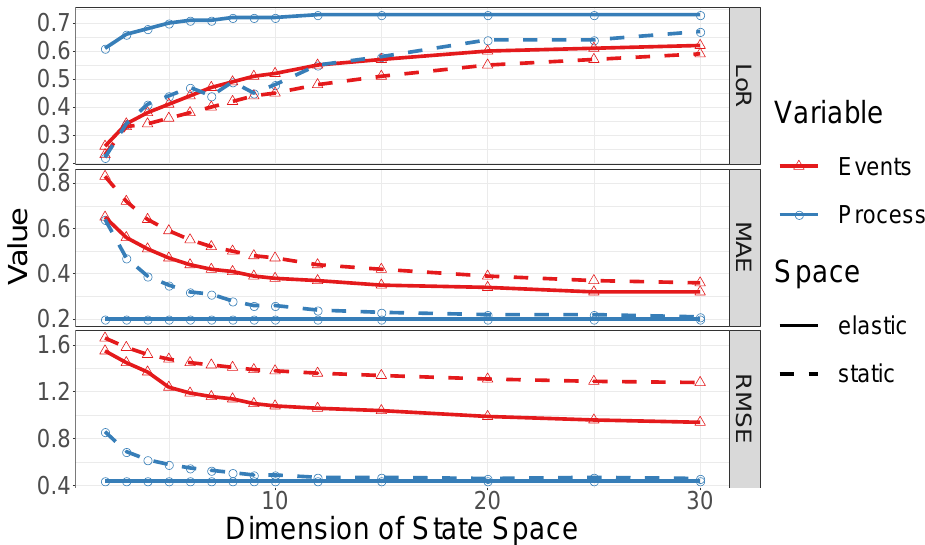
Figure 8. Evaluation of prediction accuracy of the MC-E and MC-P models in terms of MAE, RMSE and LoR (30 s interval) for increasing dimensions of the state space defined elastically (solid) and statically (dashed).